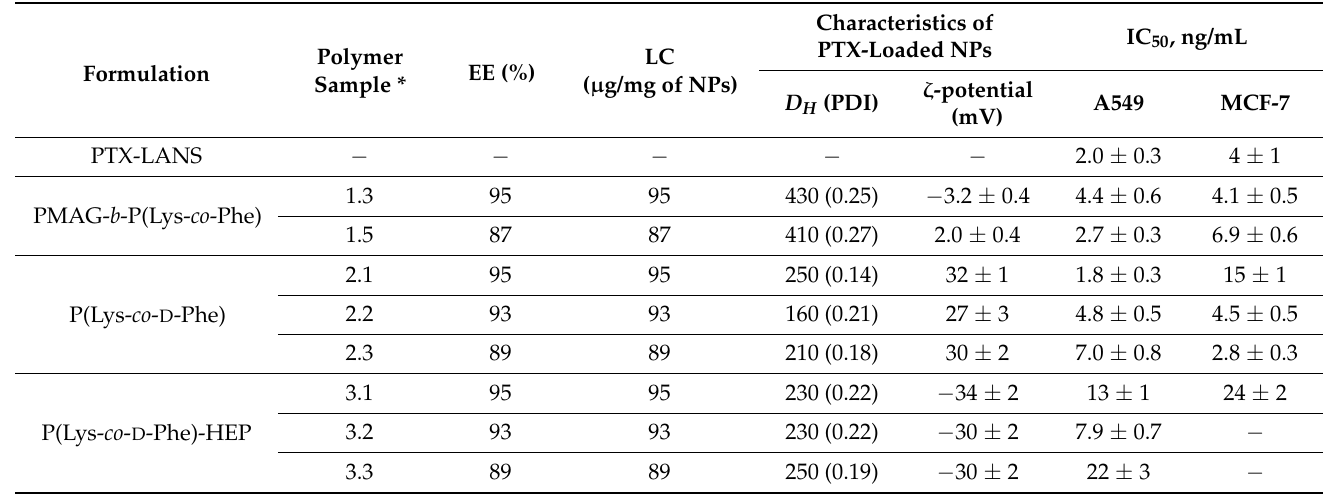
Table 4. Characteristics of paclitaxel-loaded NPs and cytotoxic effect of the developed paclitaxel